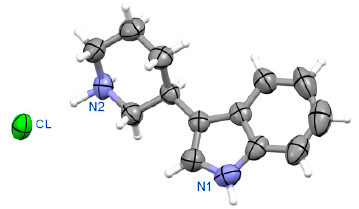
Figure 11. Perspective view of molecule (S)-11a.